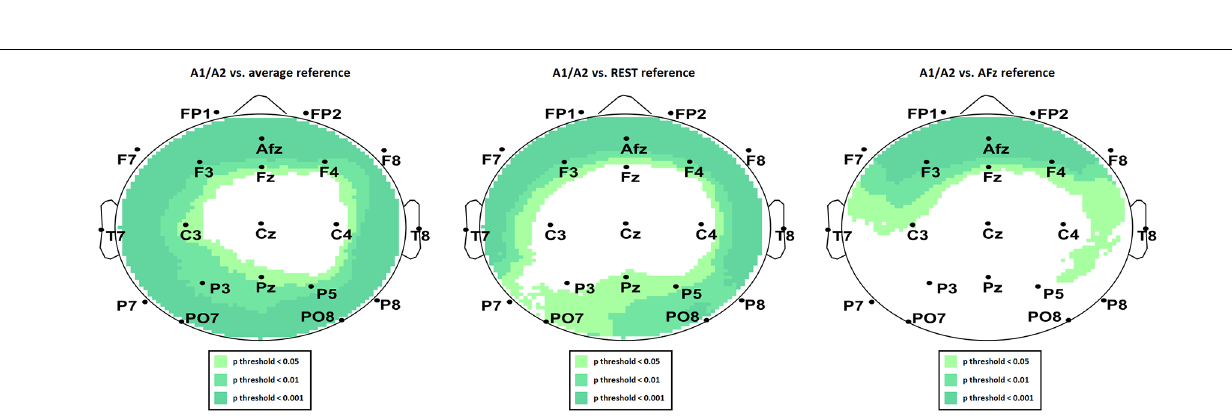
FIGURE 8 | Scalp activation for the selected ICs for 12 subjects with AFz as the reference site. The color-coding indicates the activation of the components in dB. The average activation is plotted in the top-left corner, including detailed electrode locations.